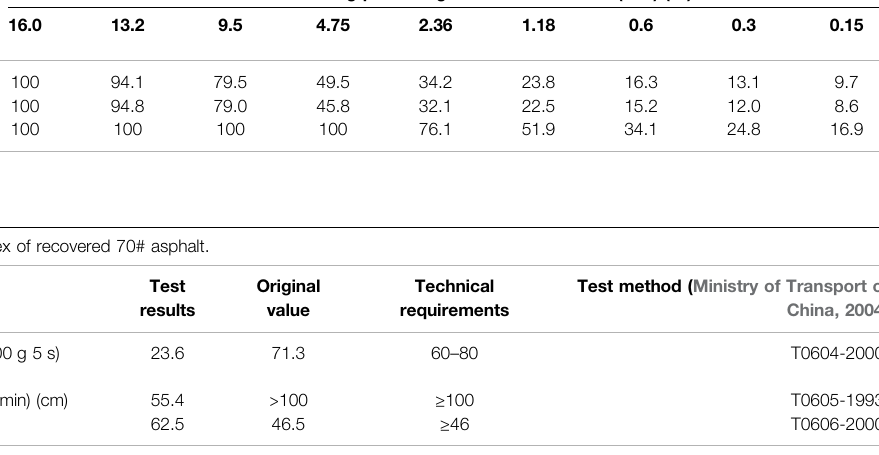
TABLE 2 | Results of recovered AC-13 modi fi ed asphalt mix components. Grouping